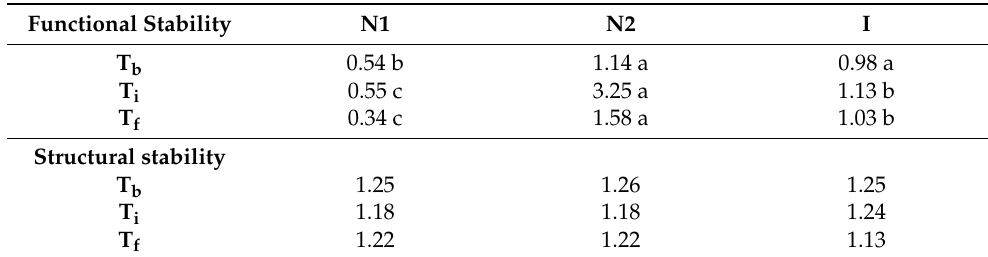
Table 3. MAI values based on all soil microbial groups and enzyme activities for each soil (N1, N2, I) at each sampling time (T b , T i , T f ). Different letters, if present, indicate significant differences (for α = 0.05) among soil types at each sampling time.